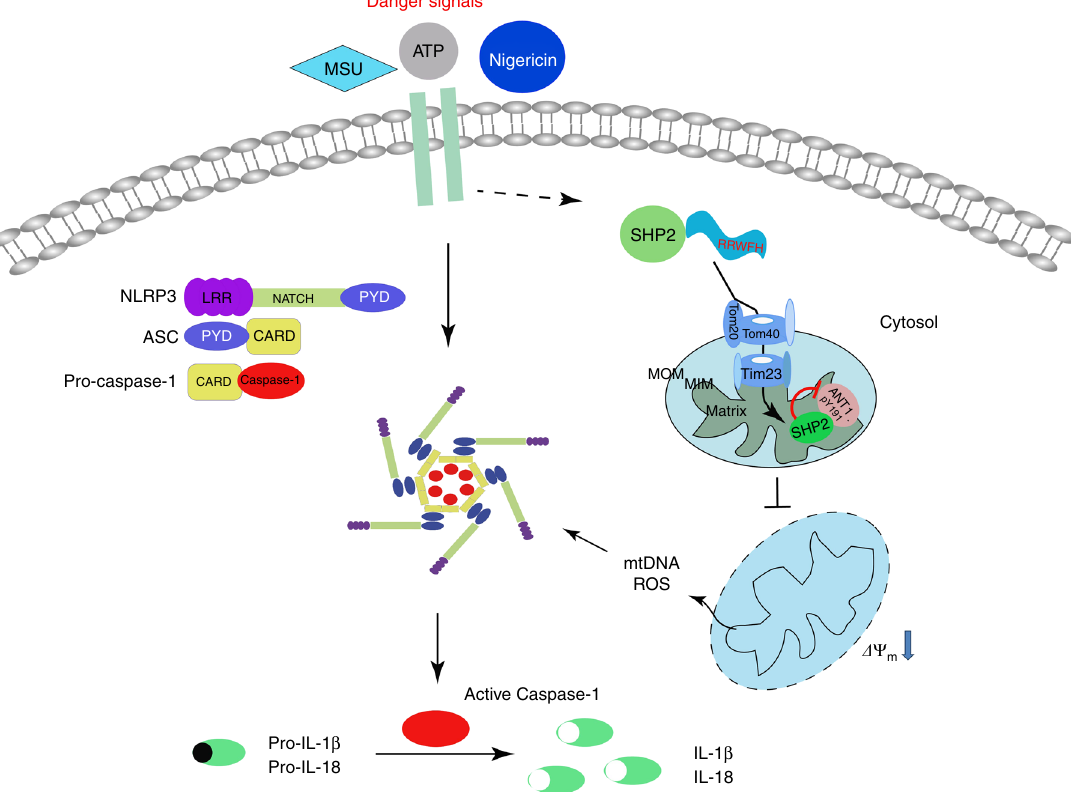
Fig. 10 The graphic illustration of the mechanism of SHP2 regulating NLRP3 in fl ammasome activation. Stimulated by Signal 2 activators (e.g., ATP, MSU, and Nigericin), SHP2 is recruited to mitochondria through its RRWFH motif. With the help of Tom20/Tom40 and Tim23 complex, SHP2 translocates into the mitochondrial matrix and dephosphorylates ANT1 at Tyr 191. This serves as a key mechanism controlling mitochondrial homeostasis, preventing leakage of mitochondrial DNA (mtDNA) and overproduction of reactive oxygen species (ROS), which results in negative regulation of NLRP3 in fl ammasome